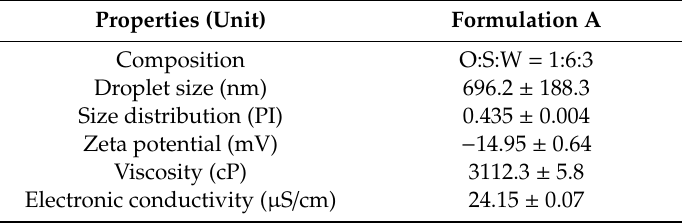
Table 1. Physicochemical properties of selected formulation.